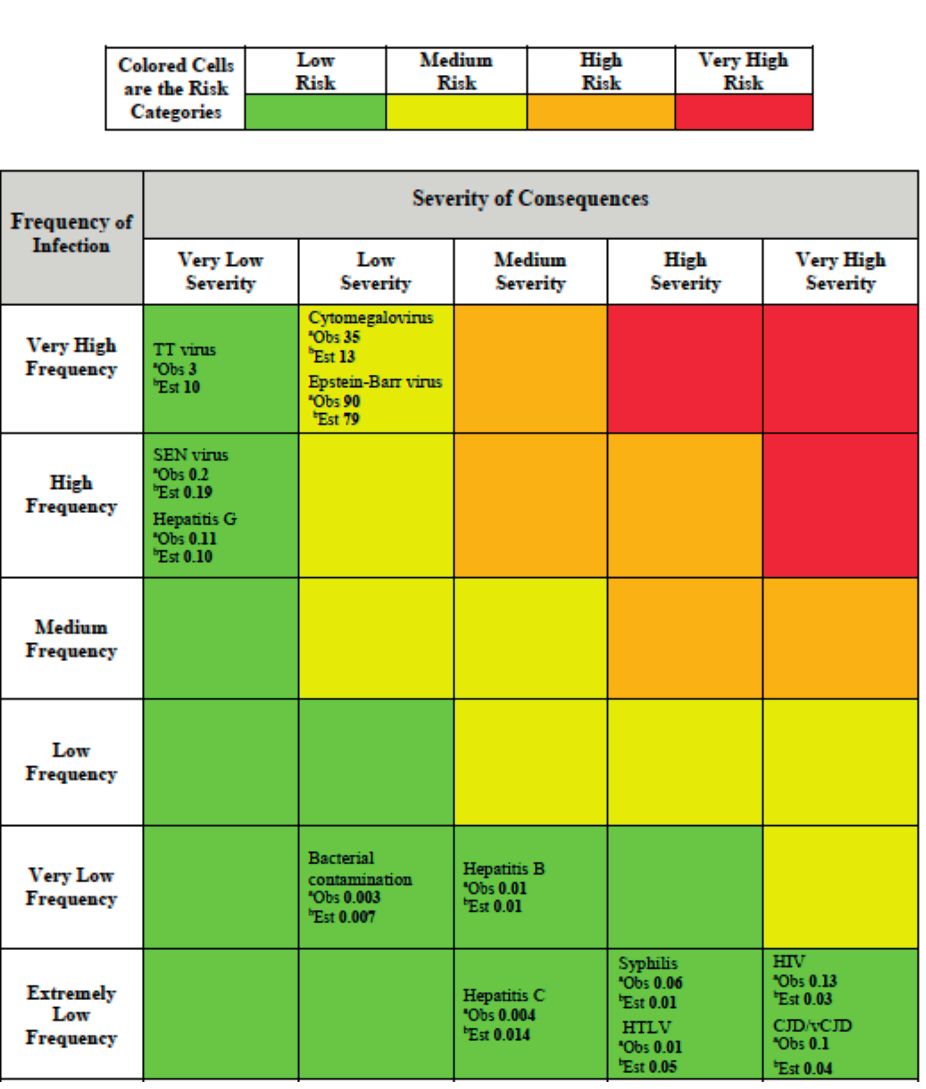
Figure 2. Risk assessment matrix providing colored risk categories plus observed and estimated risk. a Observed ( Obs ) risk numbers shown are based on the generic risk function (Risk = Frequency × Severity; Equation (1)) and using Table 1 entries for frequency and severity based on Table 2 data; b Estimated ( Est ) risk numbers shown are based on the fitted risk function Equation